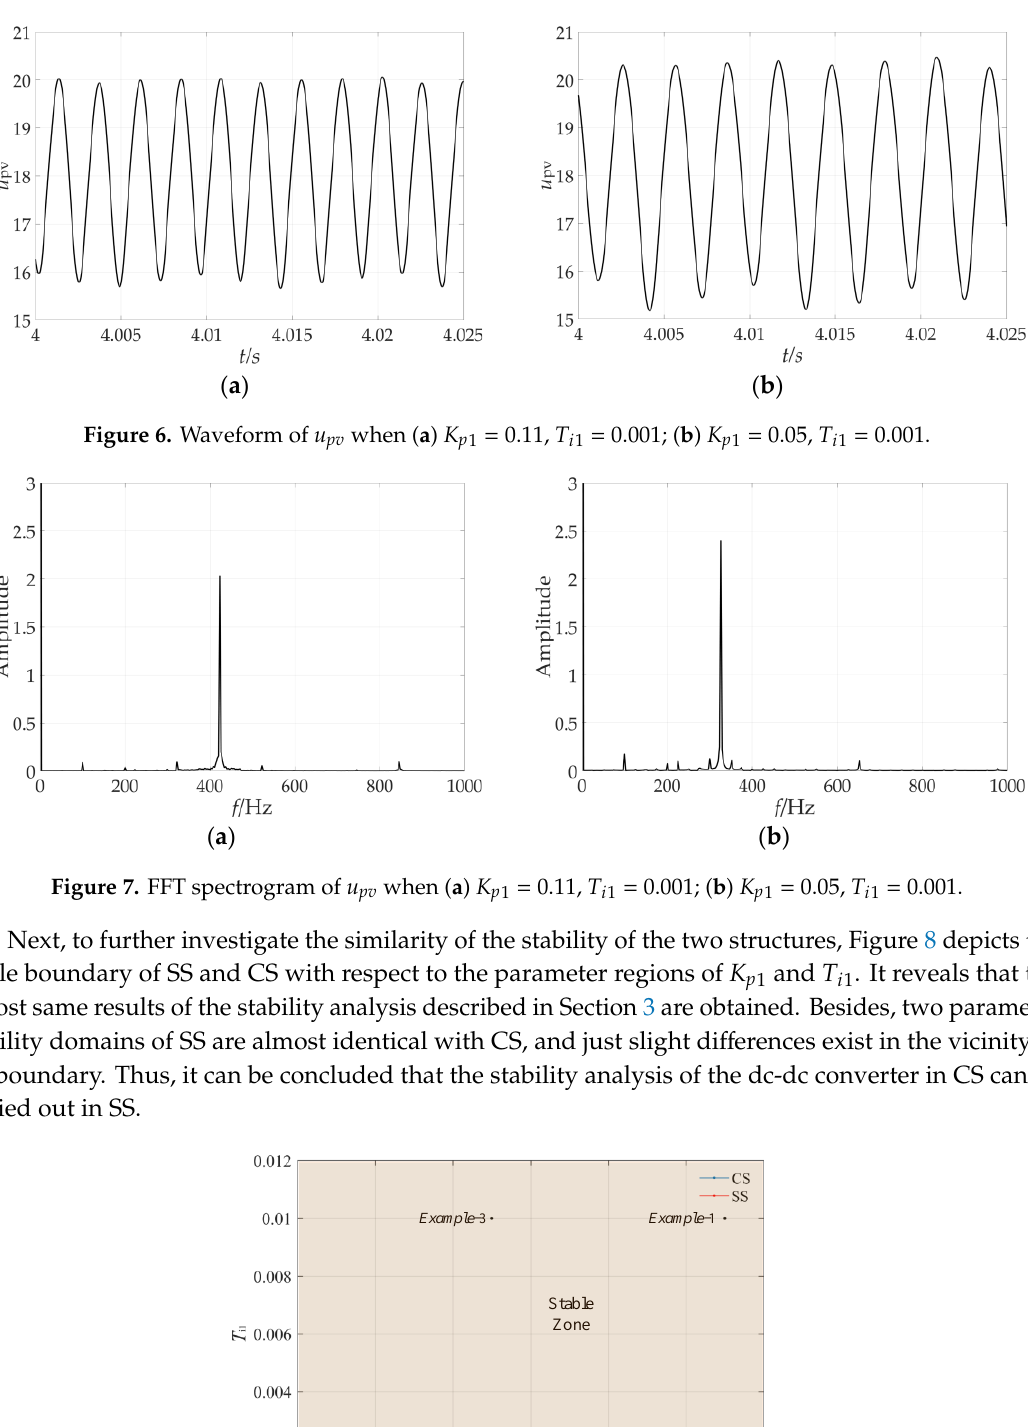
Figure 8. Comparison of stable boundary between SS and cascade structure (CS).